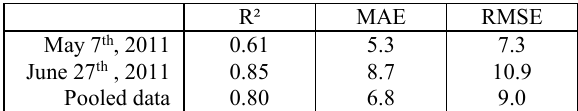
Figure 5. Scatter plot of GGC% estimated from RapidEye imagery vs. corresponding in-situ measurements of GGC% for pooled data of the May and June campaign. Table 3: Accuracy measures for GGC% estimations based on RapidEye imagery using a regional specific average soil line and an empirical full canopy point reflectance.